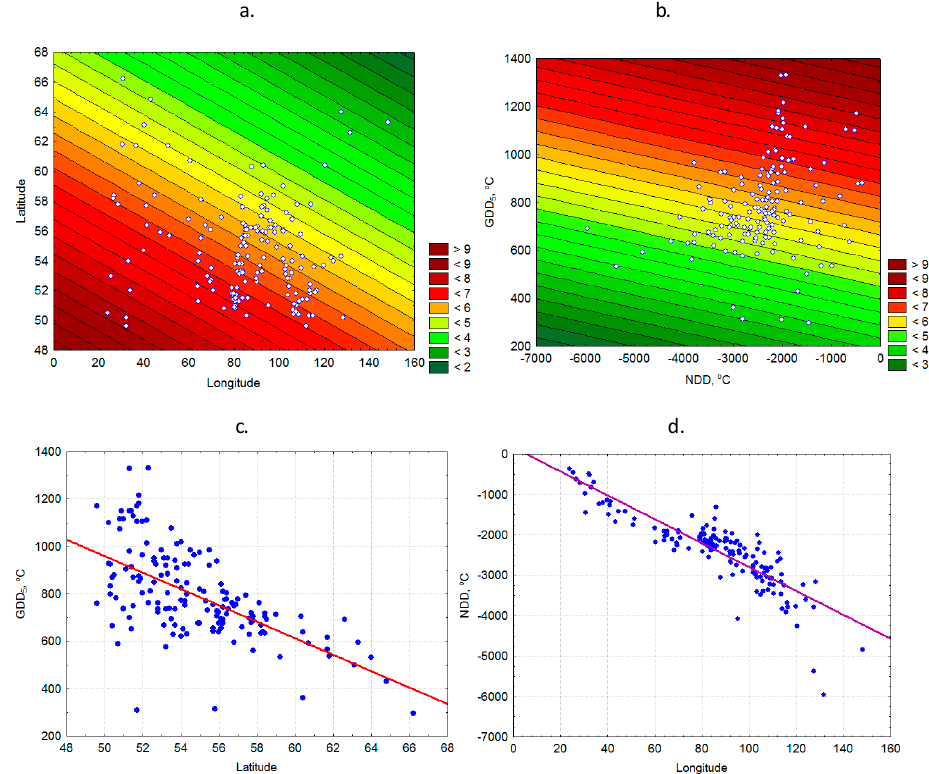
Figure 2. The dependence of Scots pine seed mass on latitude and longitude ( a ); GDD 5 and NDD ( b ); the dependence of GDD 5 on latitude ( c ); the dependence of NDD on longitude ( d ).